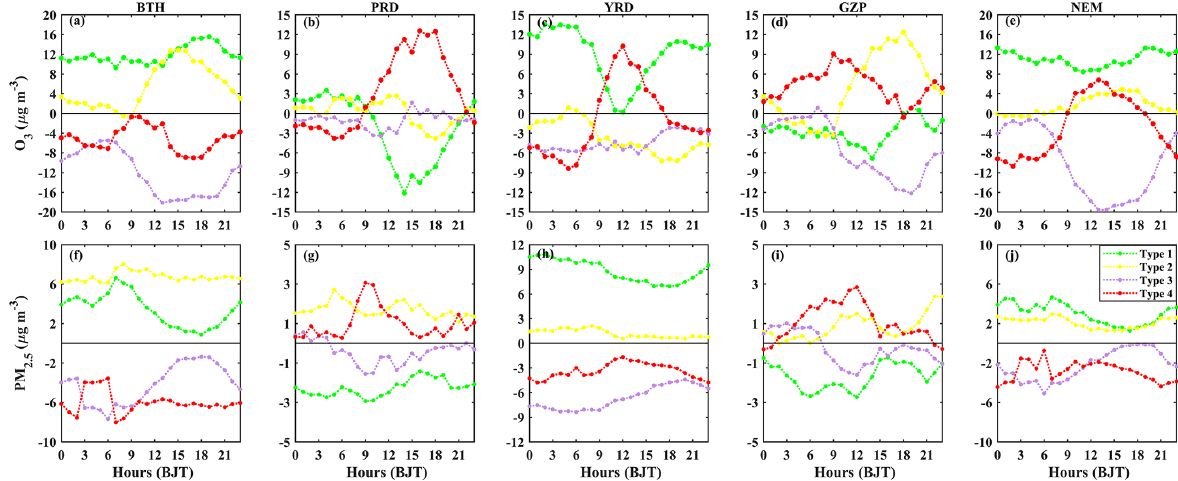
Figure 7. Daily variations of O 3 and PM 2 . 5 anomalies under the four SWPs in key urban clusters.